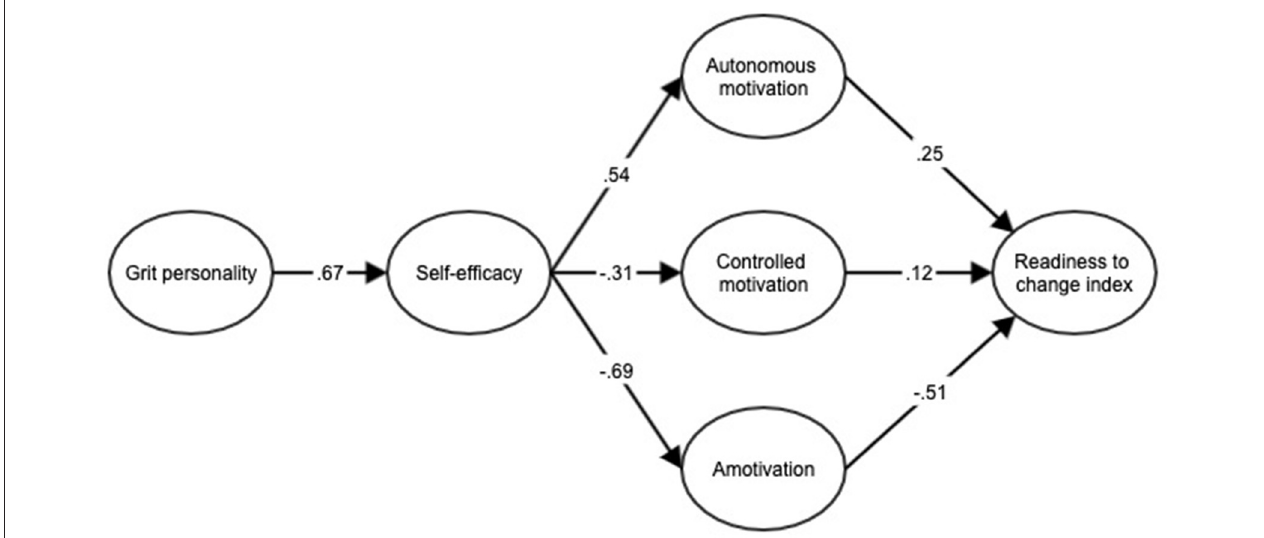
FIGURE 2 | Standardized solution of the hypothesized structural model of the relationship between grit personality, self-efficacy, motivation, and readiness to change index. All regression coefficients were significant ( p < 0.05). This figure does not include observed variables for clarity of